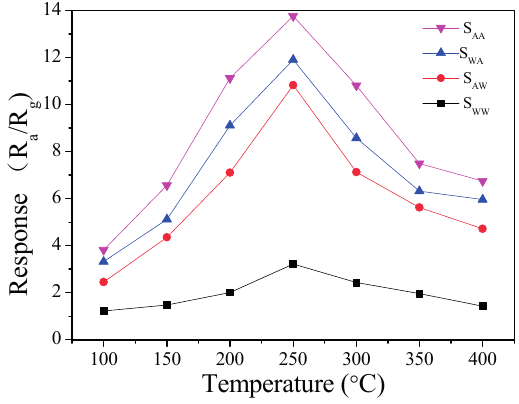
Figure 4. Response (R a /R g ) for different samples to 50 ppm acetone gas at various operating temperatures.